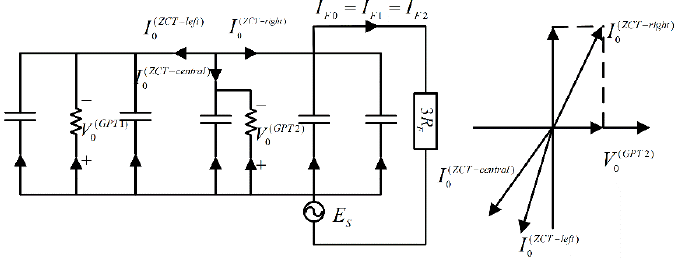
Figure 4. Simplified zero ‐ sequence networks at the photovoltaic (PV) bus for the microgrid SLG fault.